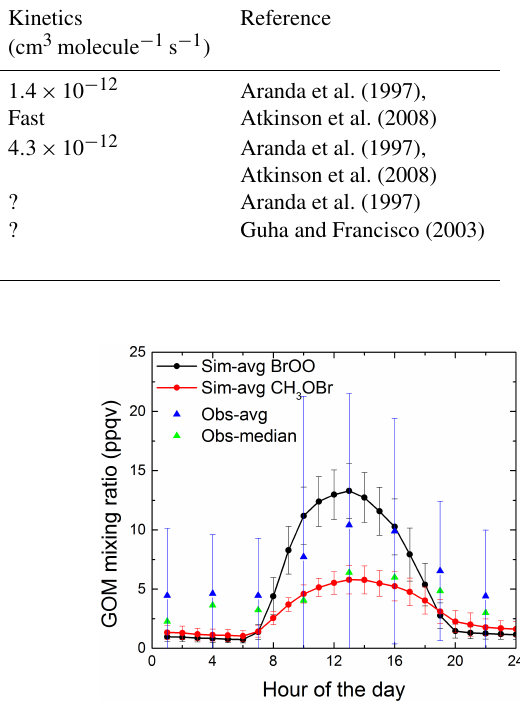
scenario (“Sim-avg BrOO”, black circle) and for the “CH 3 OBr” scenario (“Sim-avg CH 3 OBr”, red, circle), observed average GOM diurnal cycle (“Obs-avg”, blue, triangle scatter), and observed me- dian GOM diurnal cycle (“Obs-median”, green, triangle scatter) of the 50 cases at